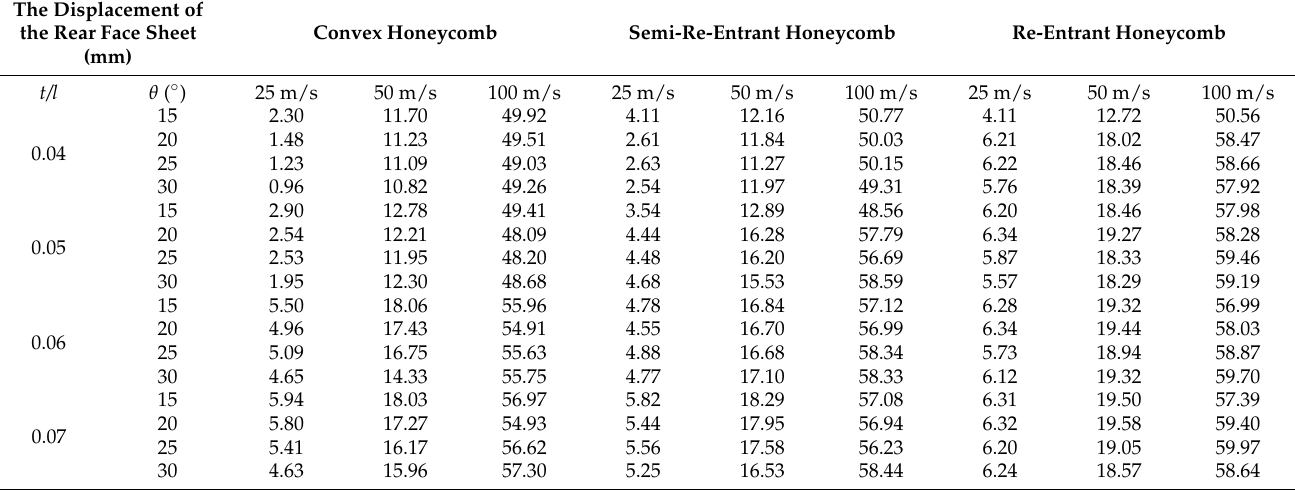
Table 3. The displacement of the honeycomb sandwich structure rear face sheet at different impact